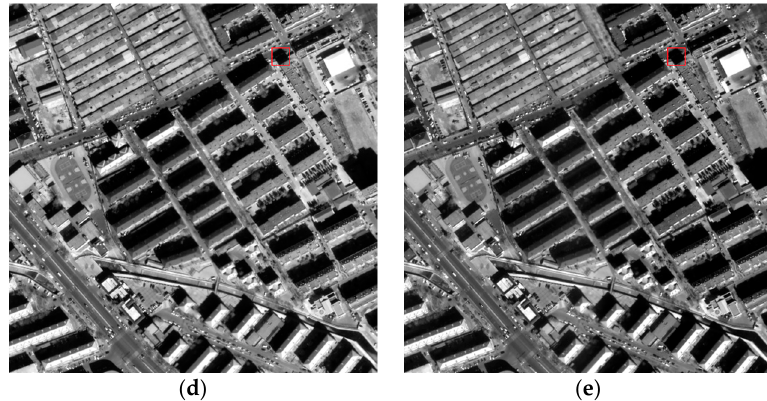
Figure 17. Raw and corrected images of the city (the images were stretched for display): ( a ) raw image; ( b ) image corrected using the polynomial fitting; ( c ) image corrected using the laboratory coefficients; ( d ) image corrected using the on-orbit coefficients; ( e ) image corrected using the proposed method.